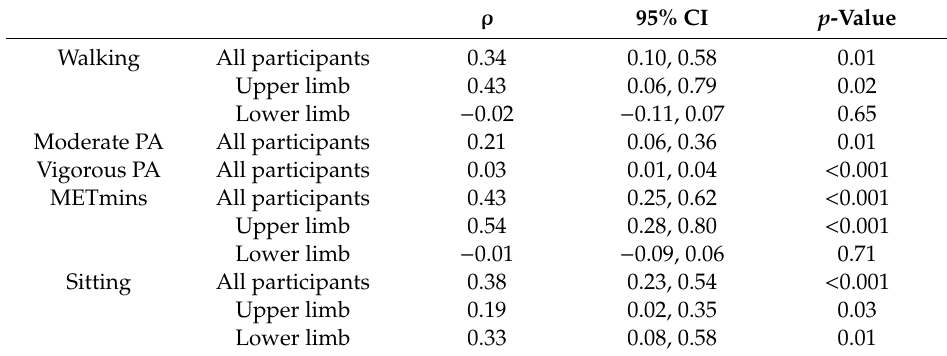
Table 4. Concordance between the International Physical Activity Questionnaire–Short Form and device-based measurement methods for assessing physical activity and sitting